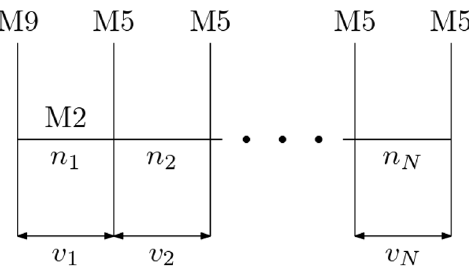
Figure 7. M9-M5 brane set-up for the rank N E-string